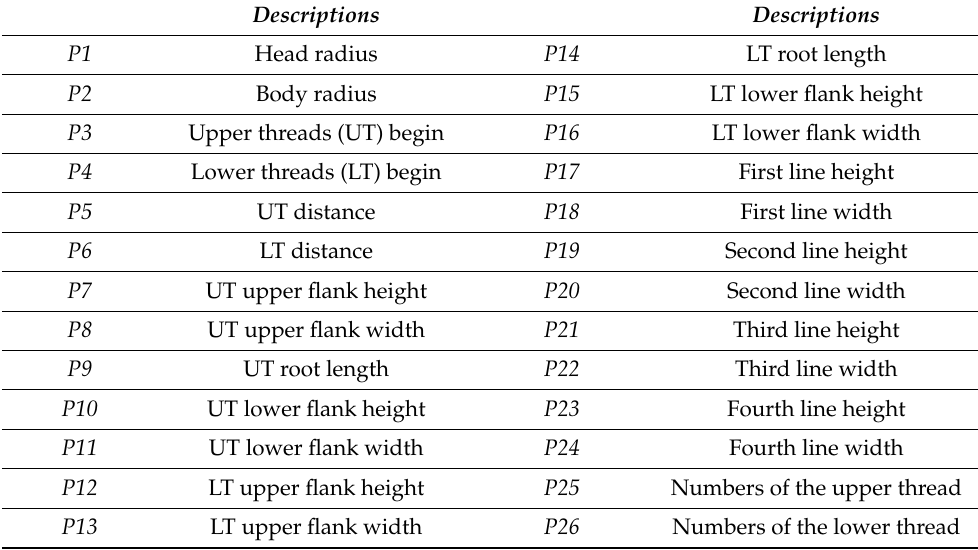
Table A3. The definition of the 26 parameters for implant geometry